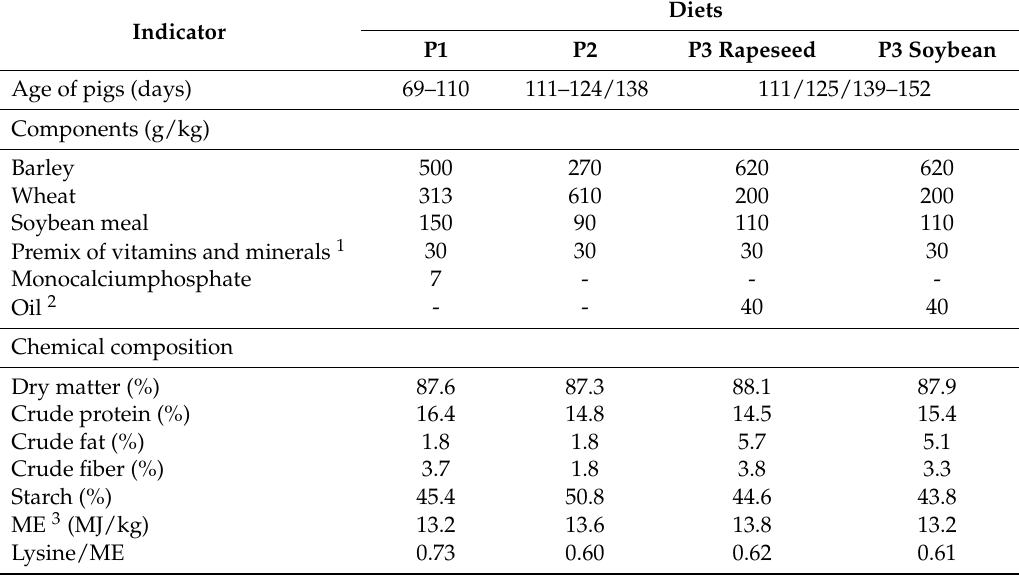
Table 1. Ingredients and chemical composition of the pig